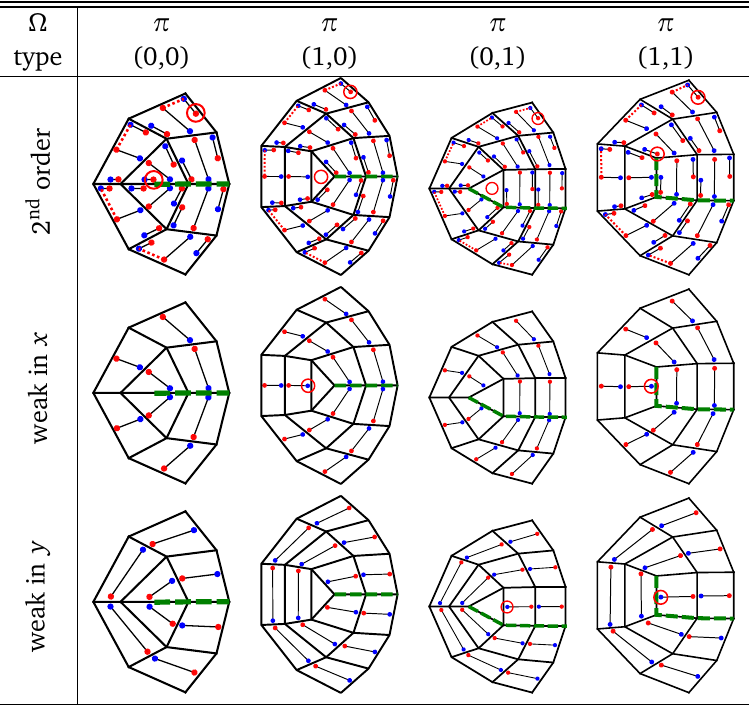
Figure C.7: Decorations of a twofold rotation symmetric lattice with π disclinations of all types with second-order topological phases protected by twofold rotation sym- metry and weak phase as a stack in x , y direction. Red and blue dots denote d − 2 dimensional anomalous states with (cid:90) topological charge ± 1. The red dashed lines denote a possible hybridization of the anomalous states on the surface. The green dashed line denotes the cut